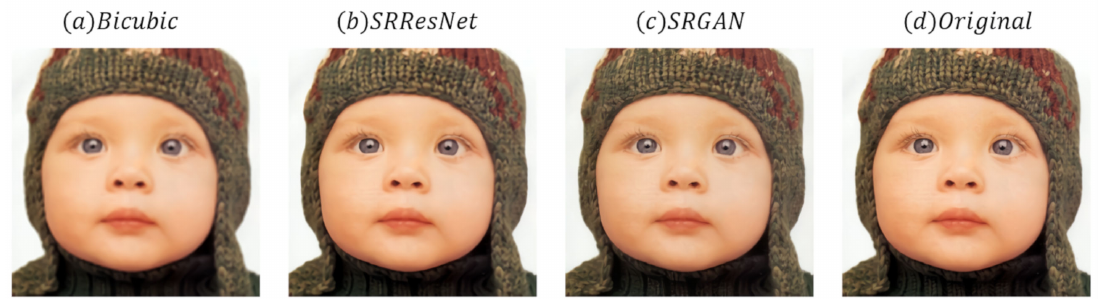
Figure 26. Comparison of super-resolution performance between SRGAN (Super Resolution Generative Adversarial Networks) and other models